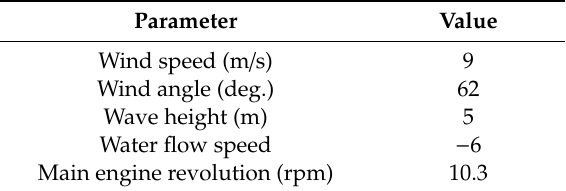
Table 1. Initial value of the navigation